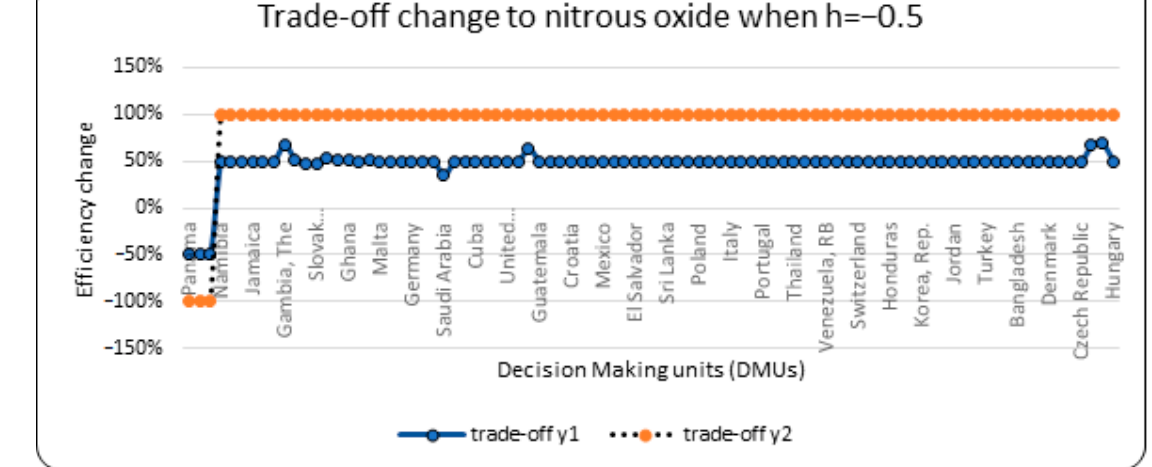
ecological deficiency